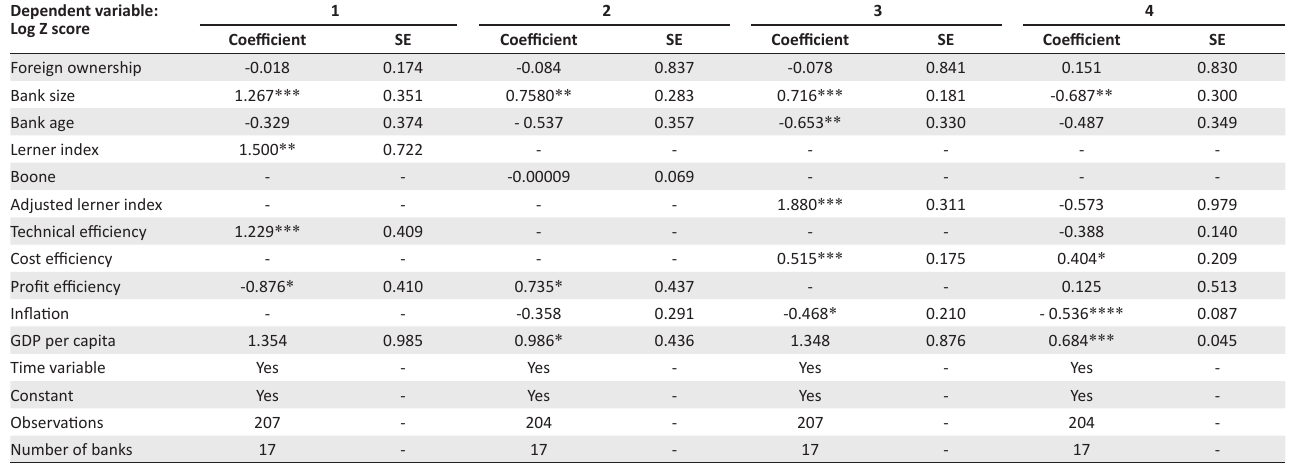
TABLE 8: Z score results. Dependent variable: Log Z